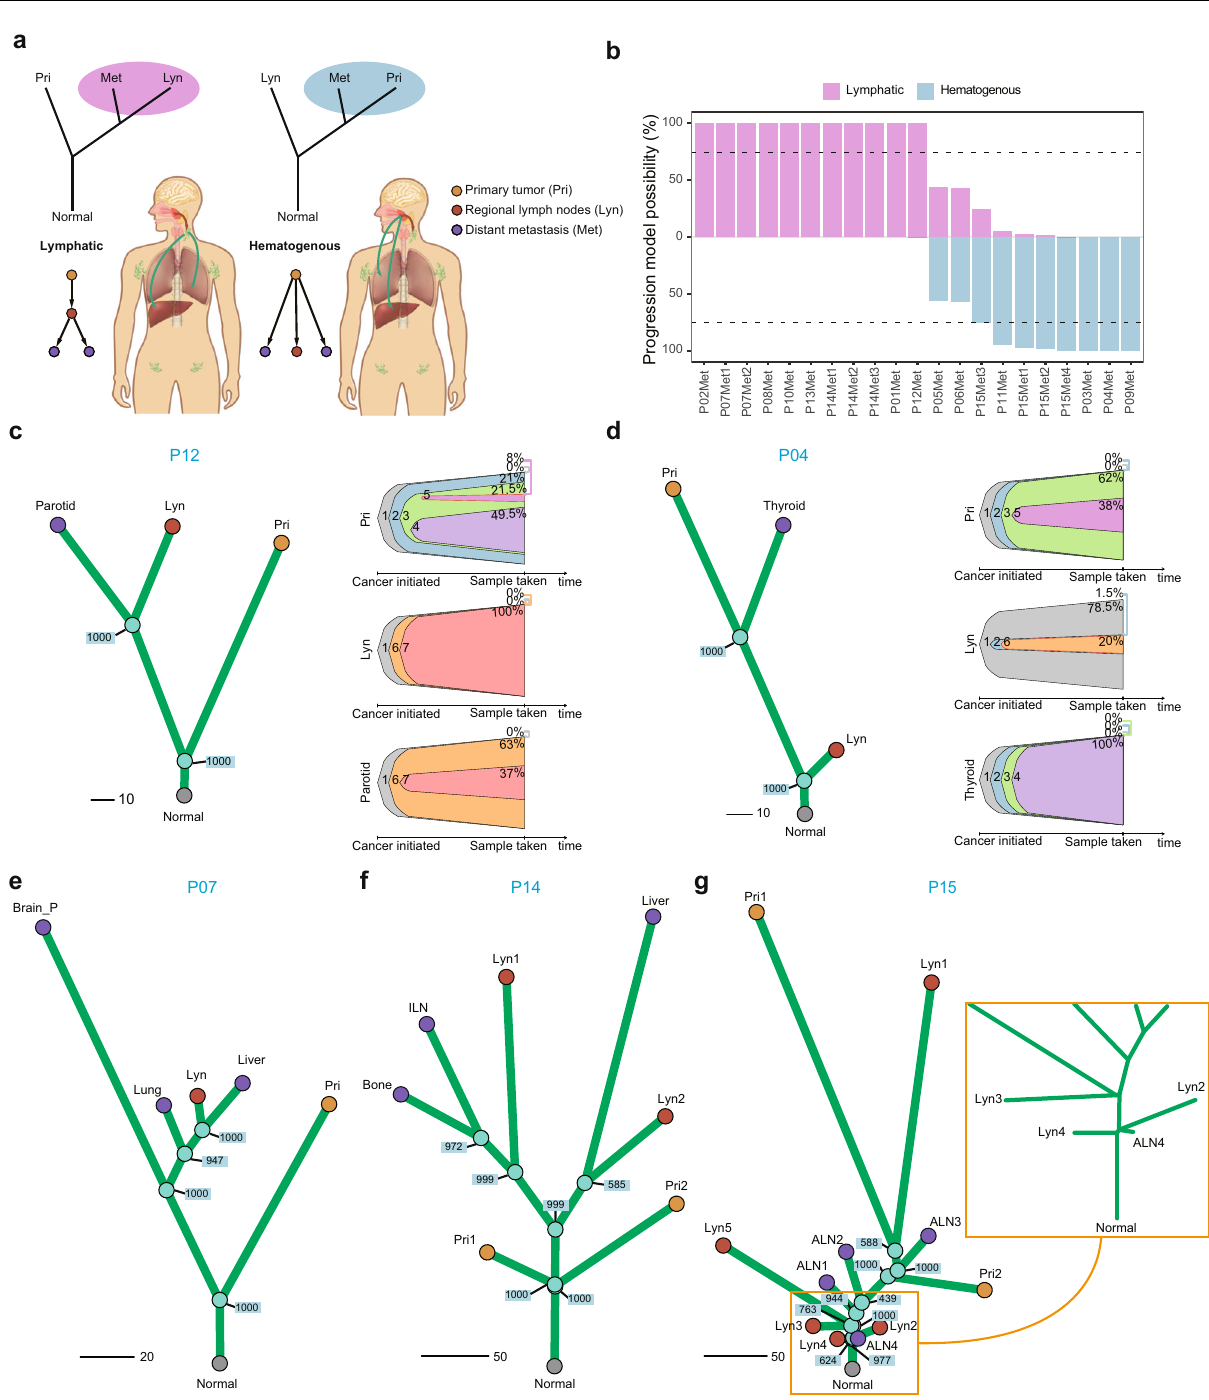
Each colour of the bell plot represents a speci fi c subclone. For the lymphatic pat- tern, one or moresubclones found inthe distant metastasiscouldalso befound in the regionallymphnodemetastasisinsteadof the primarytumour.Otherwise,this kind ofcluster is not found in the hematogenous evolutionpattern. The CCF value of each subclone in each sample at the time of sampling is marked in the bell plot. e – g Distantmetastasesshowconsistentevolutionarypatternsrevealedbypatients withmultiregionormultiorgandistantmetastases.AlldistantmetastasesfromP07 and P14 are classi fi ed as the lymphatic route ( e , f ), and all distant metastases from P15 are classi fi ed as the hematogenous route ( g ). Source data are provided as a Source Data fi